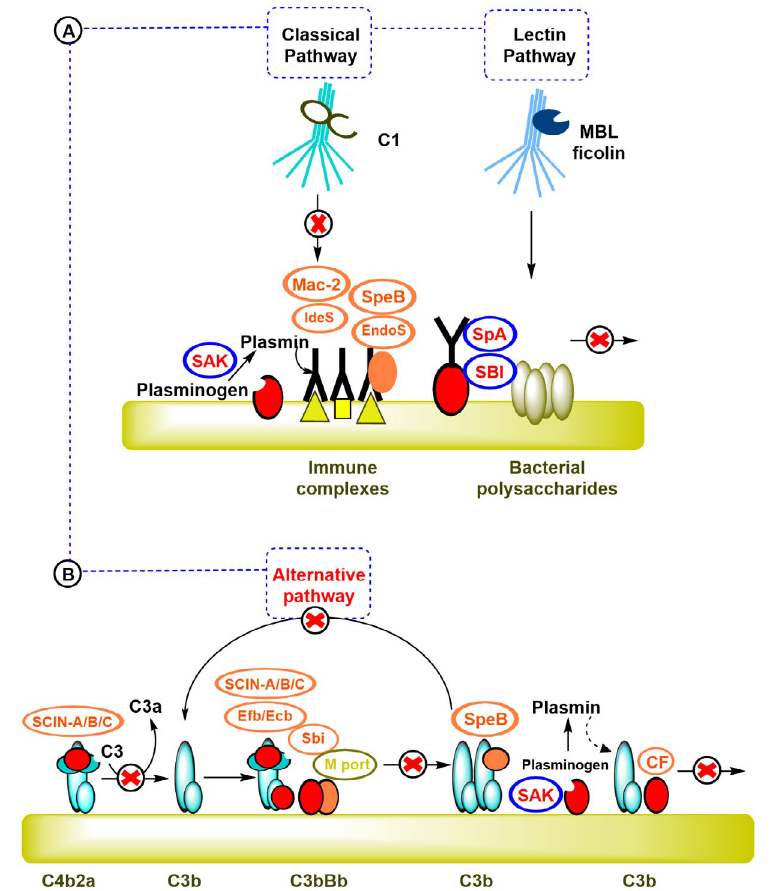
Fig. 2. Staphylococcus evasion of complement recpgnition: (A)- S. aureus produce two surface proteins that can damage and harm IgG function; Staphylococcal protein A (SpA) and Staphylococcal immunoglobulin binding protein (Sbi). (B)- Presence of the C3 convertases is significant for the activation of complement system and for the response of host immune cells. S. aureus use three ways to affect and change this vital step in the complement cascade [17, 18, 19]